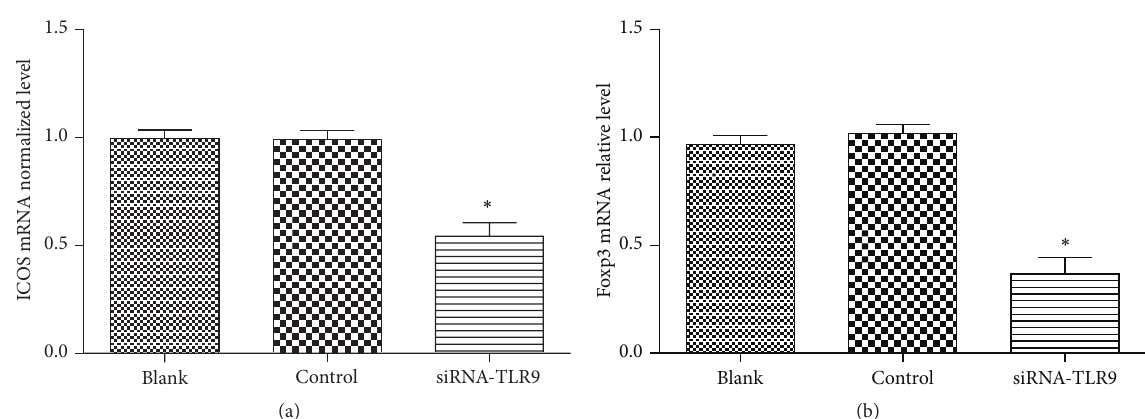
Figure 5: Influence of TLR9 expression on the downstream signals expression: (a) silenced TLR9 caused the downregulation of ICOS; (b) silenced TLR9 caused the downregulation of Foxp3. ∗ 𝑃 < 0.05 , compared with the